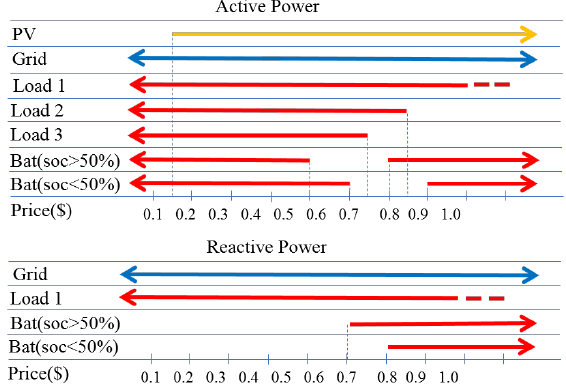
Figure 21. Specified purchase and sale prices for each MG